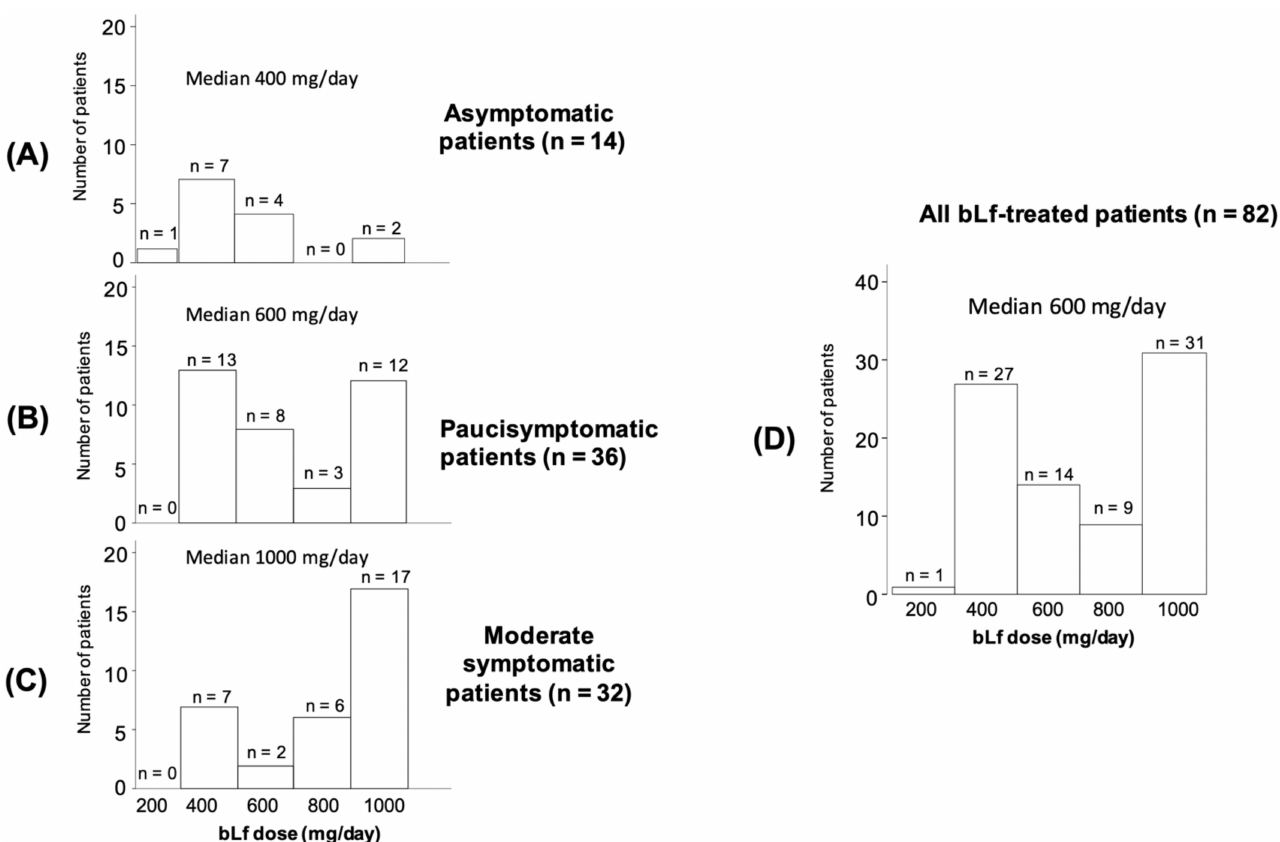
Figure 2. Bovine lactoferrin (bLf) doses in asymptomatic ( A ), paucisymptomatic ( B ), moderate symptomatic ( C ), and total patients ( D